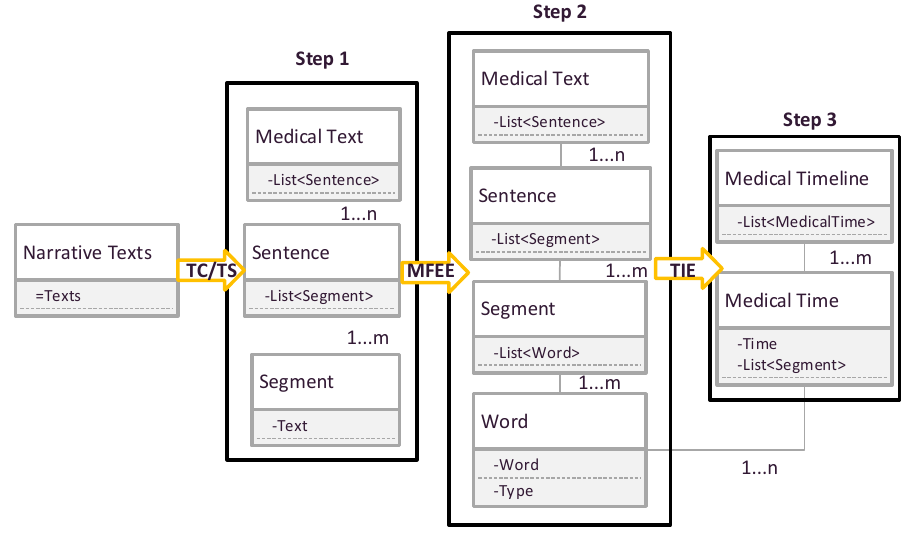
Figure 3. Data flow and data format in the MTRTI.